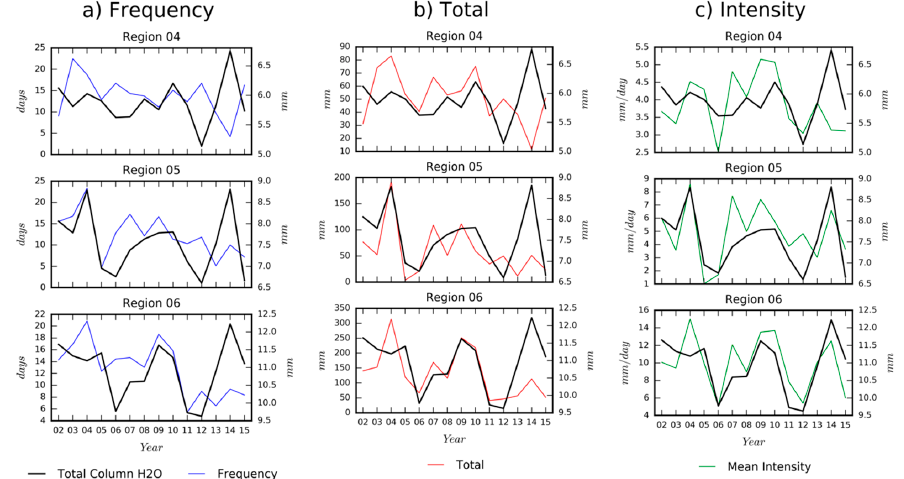
Figure 10. The time series of ( a ) frequency in days (blue), ( b ) totals in mm (red), and ( c ) mean daily intensity in mm/day (green), with total column water vapor in mm (black) within the sub-regions 4–6.